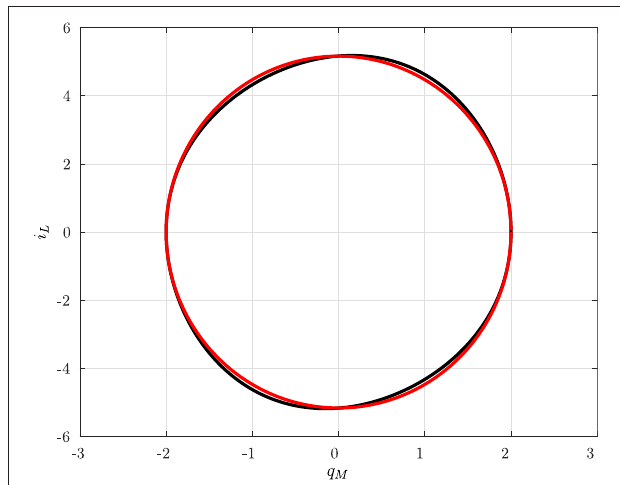
FIGURE 6 | Input-less circuit attractors: stable (green ⋆ ) equilibrium points and stable PLCs (solid green) given by Equations (27) and (28) as a function of the manifold index Q 0 . The red circles denote the unstable equilibrium points.